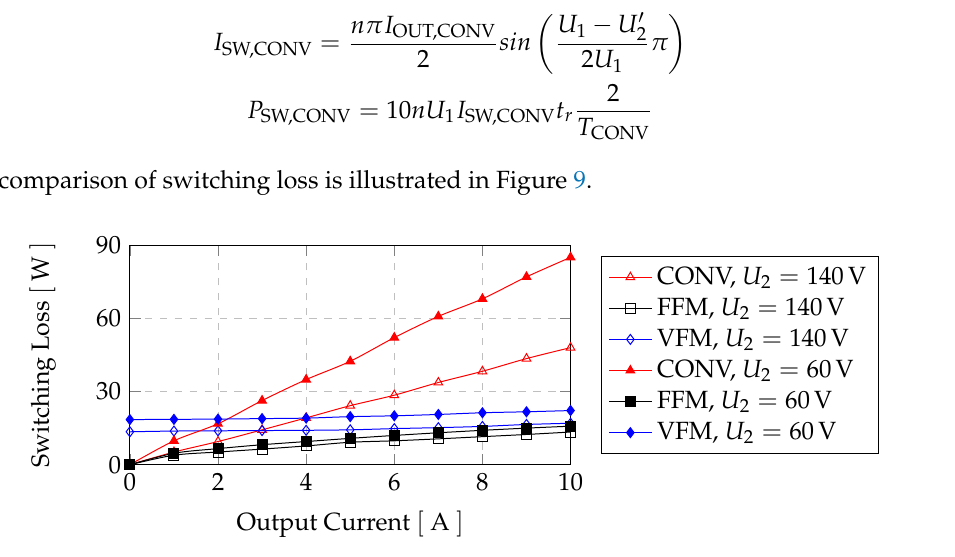
Figure 9. Switching loss of three converters ( U 1 =